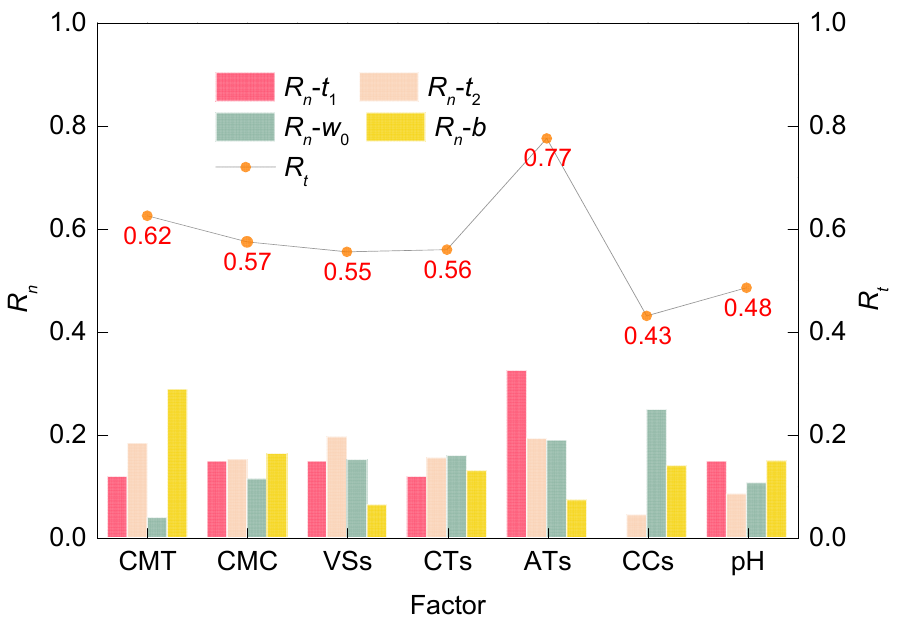
Figure 9. Degree of influence of seven factors on the four parameters.